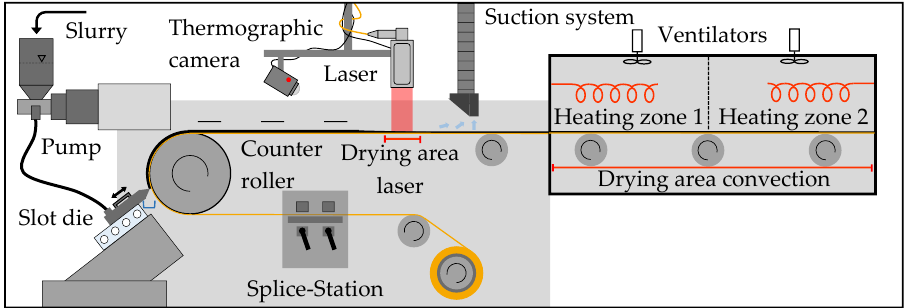
Figure 1. Schematic set-up of the coating and drying process with laser and convection [6]. A slot die coating system (Robert Bürkle GmbH, Freudenstadt, Germany) with ad- justable web speed was used. The material flow rate of the slurry was regulated by the speed of the pump. The distance from slot die to copper foil was 200 µm. In the subsequent drying process, either a laser system or a convection dryer was used. The laser system consisted of a diode laser (LDM 8000 W, Laserline GmbH, Mülheim-Kärlich, Germany) with a wavelength range of 900 to 1080 nm and a zoom optics (OTZ-5 VR, Laserline GmbH), focusing the laser radiation vertically on a 16 cm (coating width) × 17 cm (length) spot of the coated foil. The laser voltage and intensity were adjusted through a control panel. A thermographic camera (Xi 400, Optris GmbH, Berlin, Germany) recorded the la-